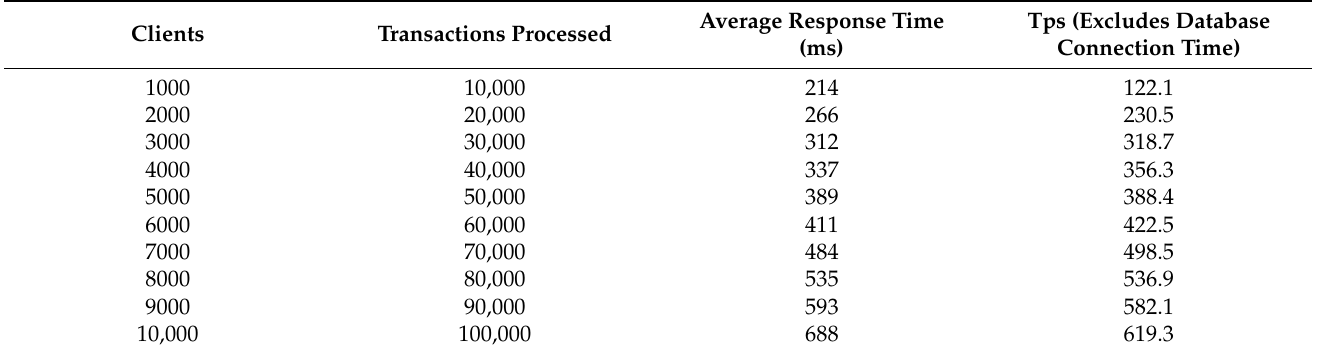
Table 2. Results regarding the testing of the database and the use of its performance standards regarding the number of